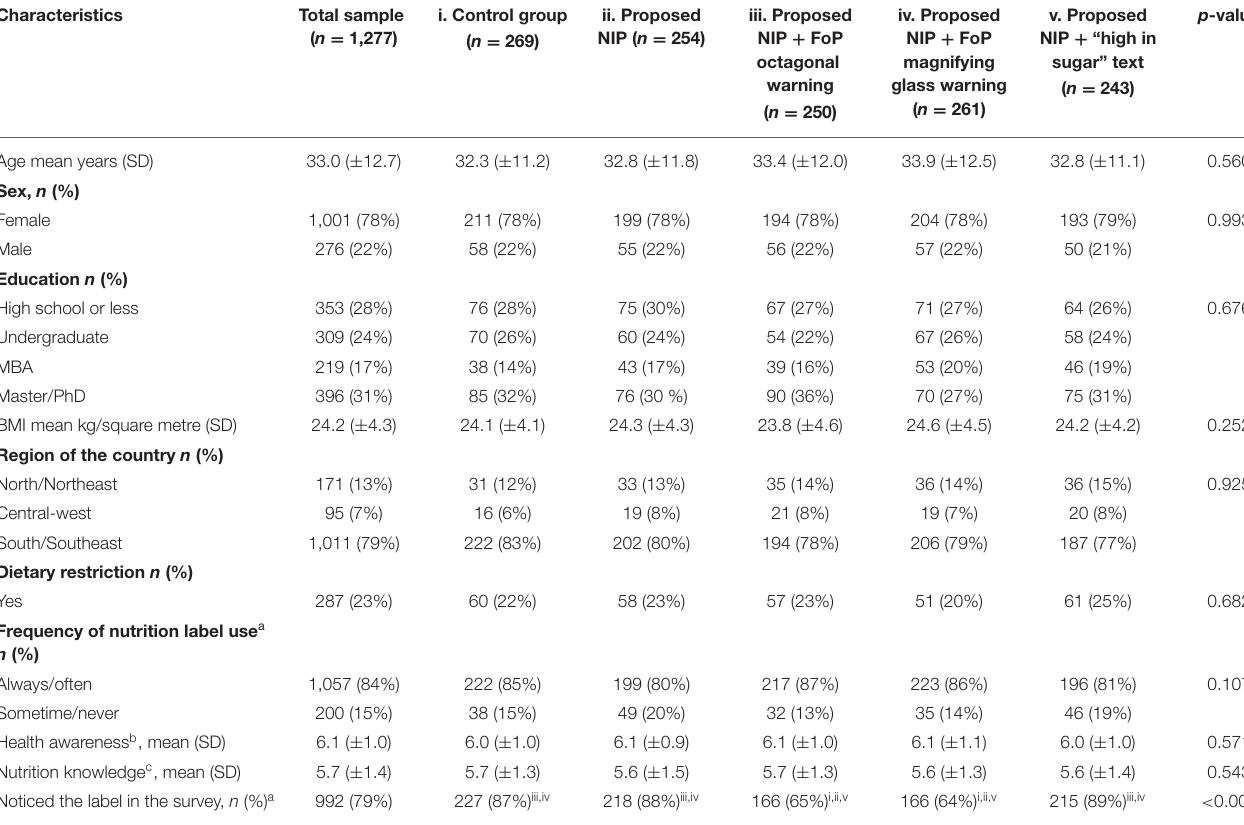
TABLE 1 | Participant characteristics, total and by label condition.